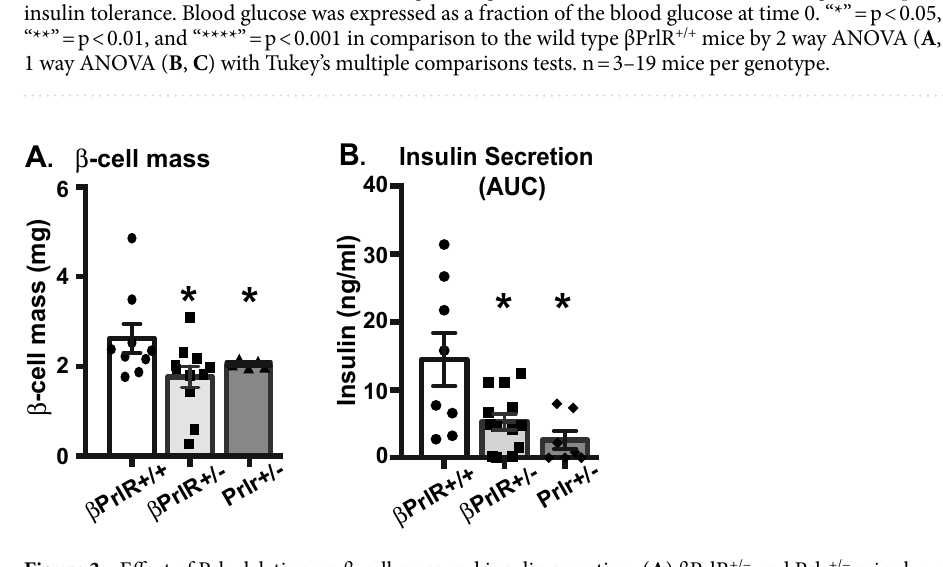
Figure 3. Effect of Prlr deletion on β-cell mass and insulin secretion. ( A ) βPrlR +/− and Prlr +/− mice have a lower β-cell mass on day 15 of pregnancy in comparison to the wild type βPrlR +/+ mice. ( B ) Insulin secreted during an IPGTT, expressed as integrated area under the curve (AUC), is lower in βPrlR +/− and Prlr +/− mice in comparison to wild type βPrlR +/+ mice. “*” = p < 0.05 in comparison to the βPrlR +/+ mice. n = 10–12